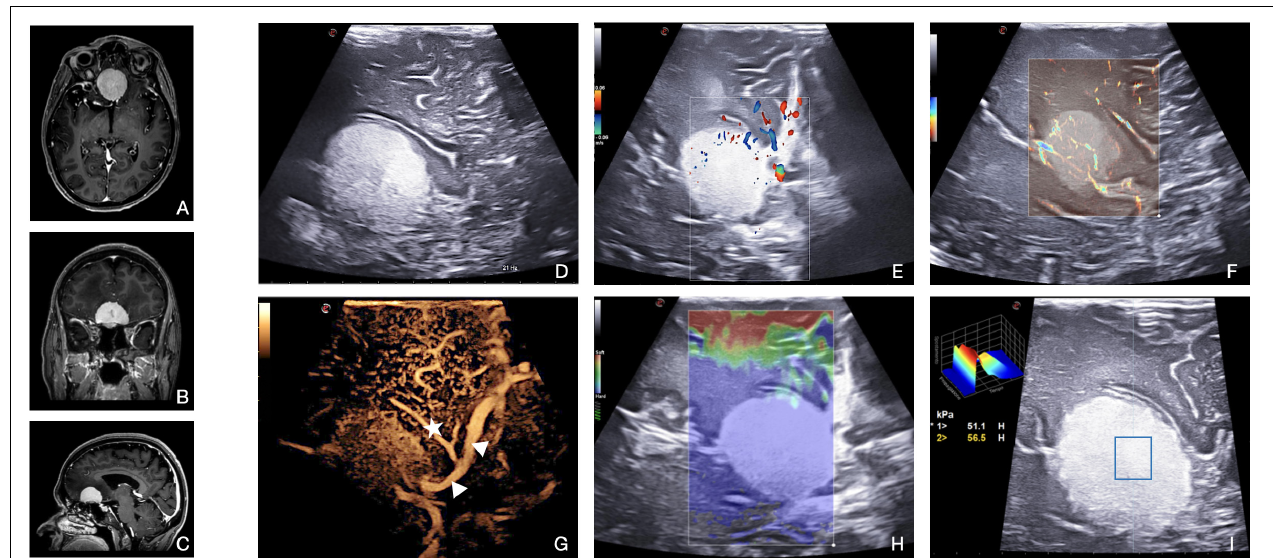
FIGURE 7 | Illustrative case of atypical meningioma (Grade 2 WHO, 2021). (A–C) Pre-operative MRI demonstrates a Planum Sphenoidale, enhancing, extra-axial tumor. (D) Standard B-mode: meningioma appears hyperechoic, compared with normal brain parenchyma, with a homogeneous pattern and a granular aspect. Tumor margins are sharply defined. (E) Color- and spectral-Doppler show the presence, direction, and velocity of flow of the vessels of the anterior circulation. (F) Micro-V depicts also slow flow in small-diameter vessels within the lesion, providing information about the entity of perfusion/vascularization. (G) CEUS enhances the findings of Doppler modalities representing a peritumoral and intratumoral vascular tree. In this patient, we can appreciate the relationships between meningioma and anterior cerebral artery (arrowheads) and Heubner’s artery (star). The basal portion of the lesion cannot be properly studied due to calcification within the meningioma itself. In meningioma surgery, elastosonography informs on lesion mechanical features, thus guiding surgical decision-making. In this case, (H) SE shows meningioma with a higher stiffness than the surrounding tissues. (I) SWE confirms the higher stiffness also providing a quantitative evaluation: Young’s modules in the ROI of 56